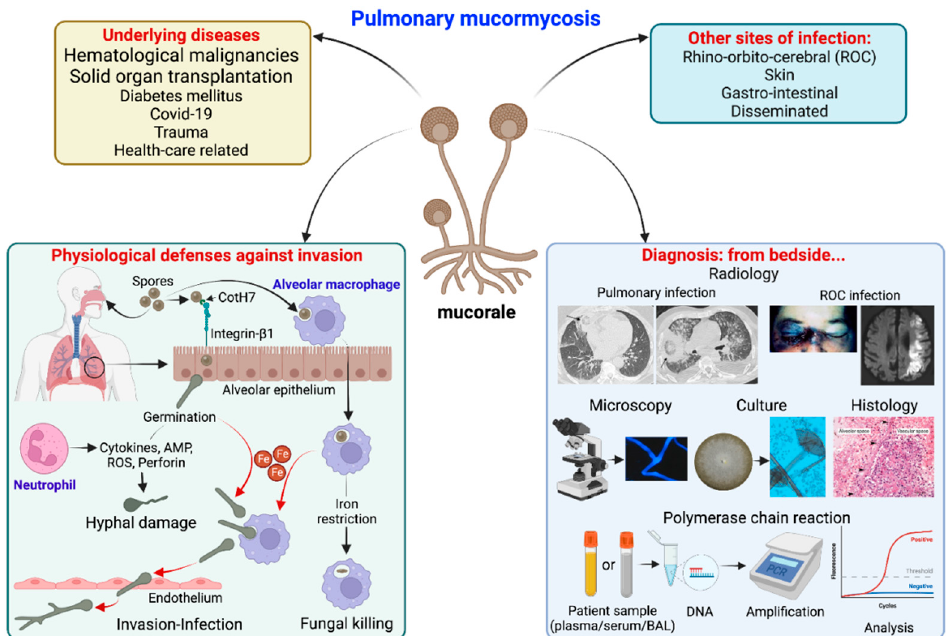
Figure 1. Summary of pulmonary mucormycosis: underlying diseases, sites of infection, physiological defenses against pulmonary invasion and diagnostic methods from the bedside. Physiological defenses in brief: alveolar macrophages can uptake Mucorales spores and restrict iron (Fe), which is essential for spore germination, resulting in spore persistence inside macrophages or their killing by defense mechanisms. On the other hand, integrin- β 1 expressed on alveolar epithelial cells can recognize CotH7 on spores, facilitating spore internalization-germination. These germinating spores are recognized by neutrophils, which produce defensive molecules [cytokines, antimicrobial peptides (AMP), reactive oxygen species (ROS) or perforins] that result in hyphal damage. On the other hand, spores germinate in presence of Fe (both inside and outside macrophages) and invade endothelial cells resulting in invasion.